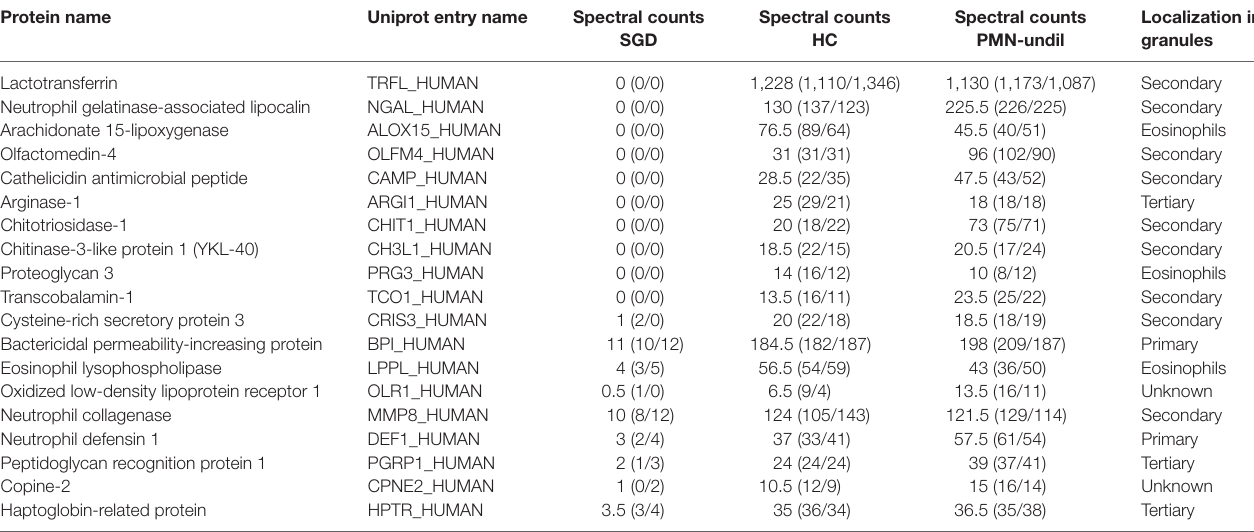
TaBle 1 | Total cell lysates of myeloid cells from specific granule deficiency (SGD) patients and healthy controls (HCs) and a polymorphonuclear (PMN)-undil fraction of HCs were prepared as in Figures 4F,g